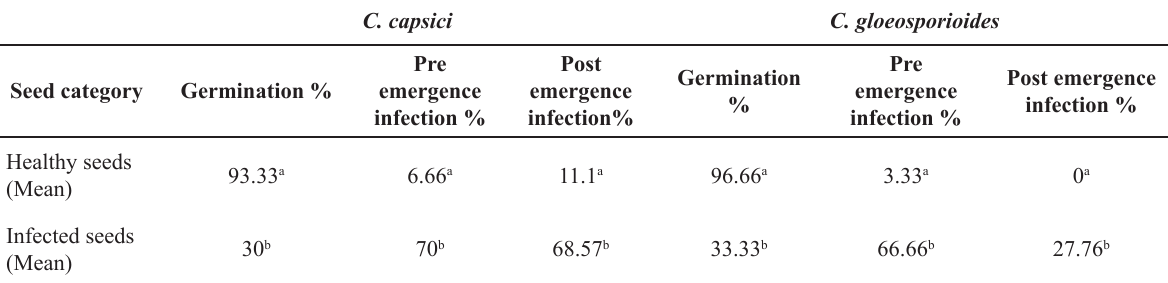
Table 4: Seed borne nature of C. capsici and C. gloeosporioides on seed quality parameters (pot culture studies).